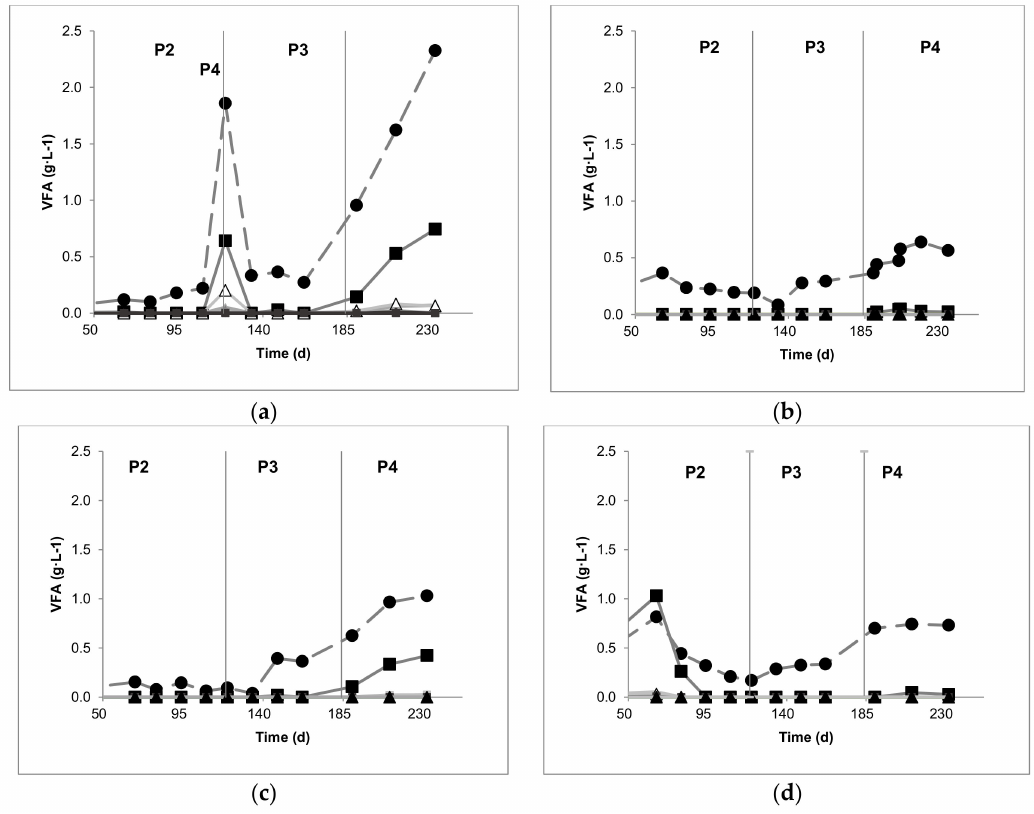
Figure 6. Evolution of volatile fatty acids (VFA) per reactor and period: ( a ) R1, ( b ) R2, ( c ) R3, ( d ) R3. Symbols: Acetic ( (cid:8) ), propionic ( (cid:4) ), i-butyric ( (cid:78) ), n-butyric ( n-caproic ( (cid:3)